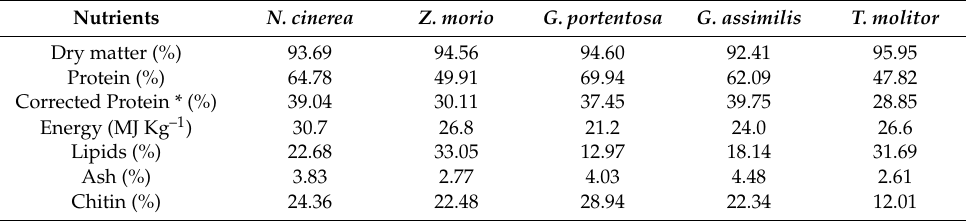
Table 1. Centesimal composition analysis of the insect meals (dry matter basis).